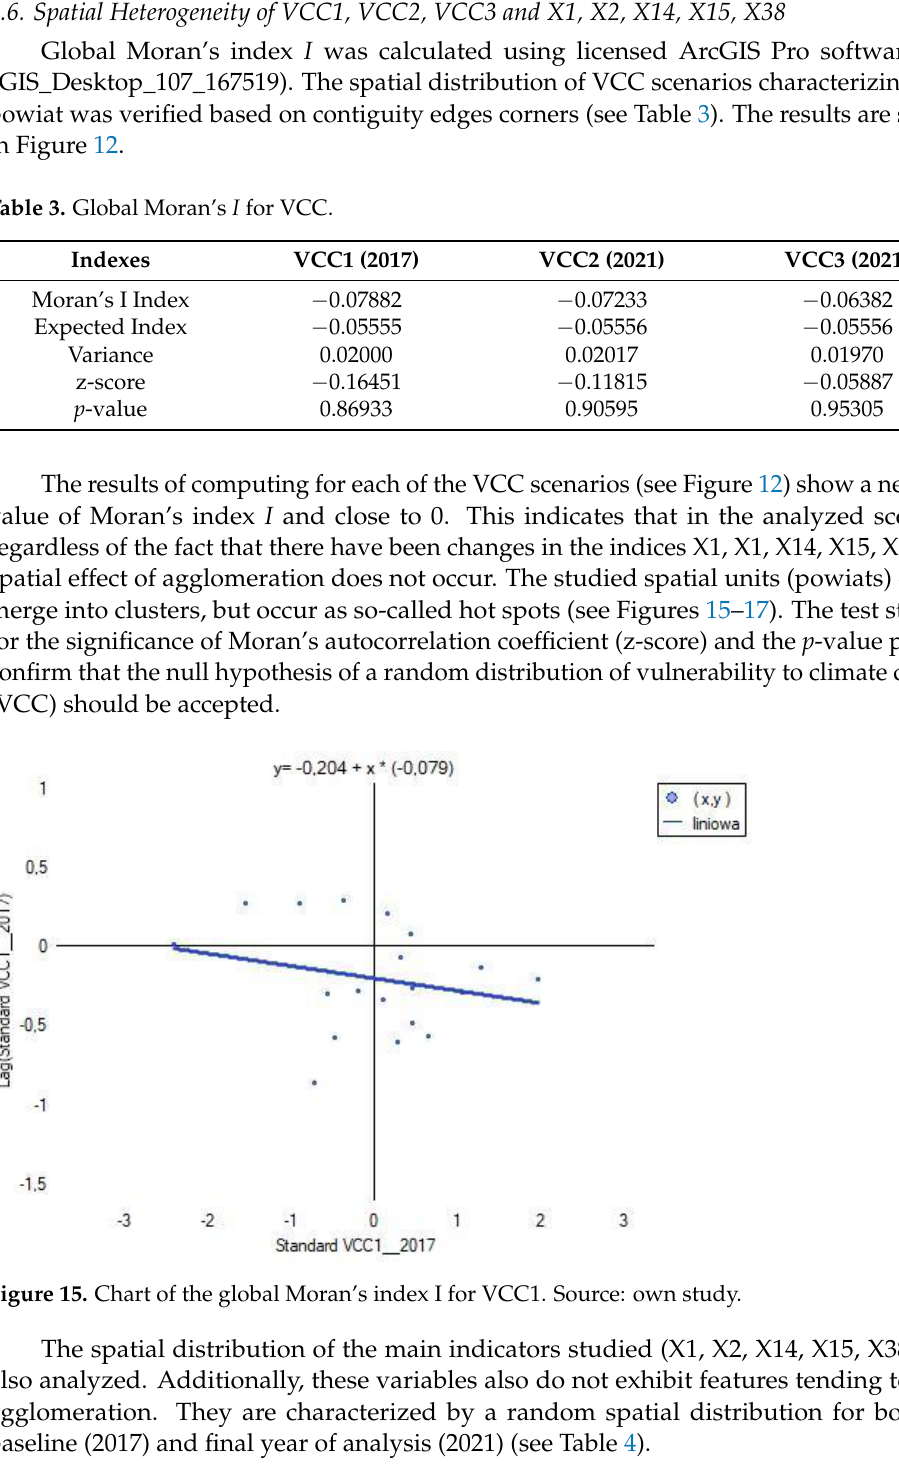
Figure 16. Chart of the global Moran’s index I for VCC2. Source: own study. Figure 17. Chart of the global Moran’s index I for VCC3. Source : own study. The spatial distribution of the main indicators studied (X1, X2, X14, X15, X38) was also analyzed. Additionally, these variables also do not exhibit features tending toward agglomeration. They are characterized by a random spatial distribution for both the base- line (2017) and final year of analysis (2021) (see Table 4).